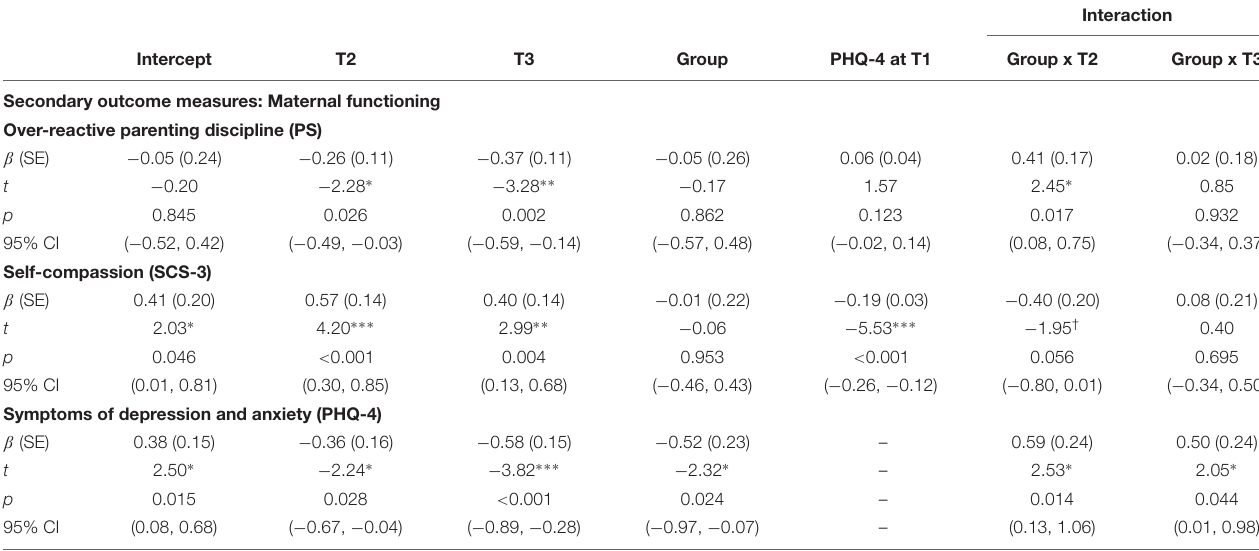
TABLE 7 | Secondary outcome measures (maternal functioning): Standardized parameter estimates (and standard errors), t and p values, and 95% confidence intervals of multilevel models of intervention outcome predicted by measurement point (T2 and T3, deviations from T1), group [intervention (reference) and waitlist control group], control variable (PHQ-4 score at T1), and interaction variables (group by T2 and T3).